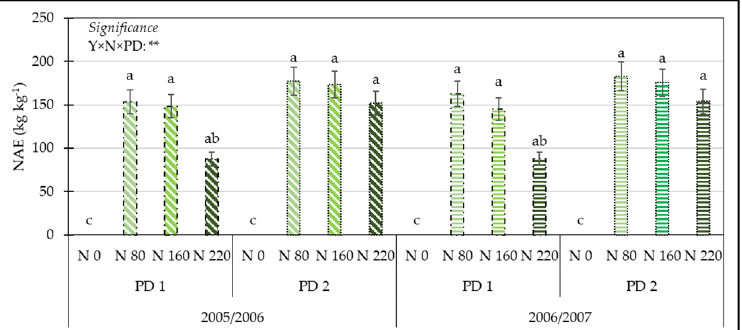
Figure 7. Influence of the interaction Y × N × PD on the NAE (nitrogen agronomic efficiency). Means followed by the same letter are not significantly different at p ≤ 0.05 according to Tukey’s test. Bars represent the standard error. ** = significant at p ≤ 0.01; Y = Year; N = nitrogen; PD = Planting Date; N 0 = No-Nitrogen Fertilization; N 80 = fertilization with 80 kg N ha − 1 ; N 160 = fertilization with 160 kg N ha − 1 ; N 220 = fertilization with 220 kg N ha − 1 ; PD 1 = Early Planting Date; PD 2 = Traditional Planting Date.